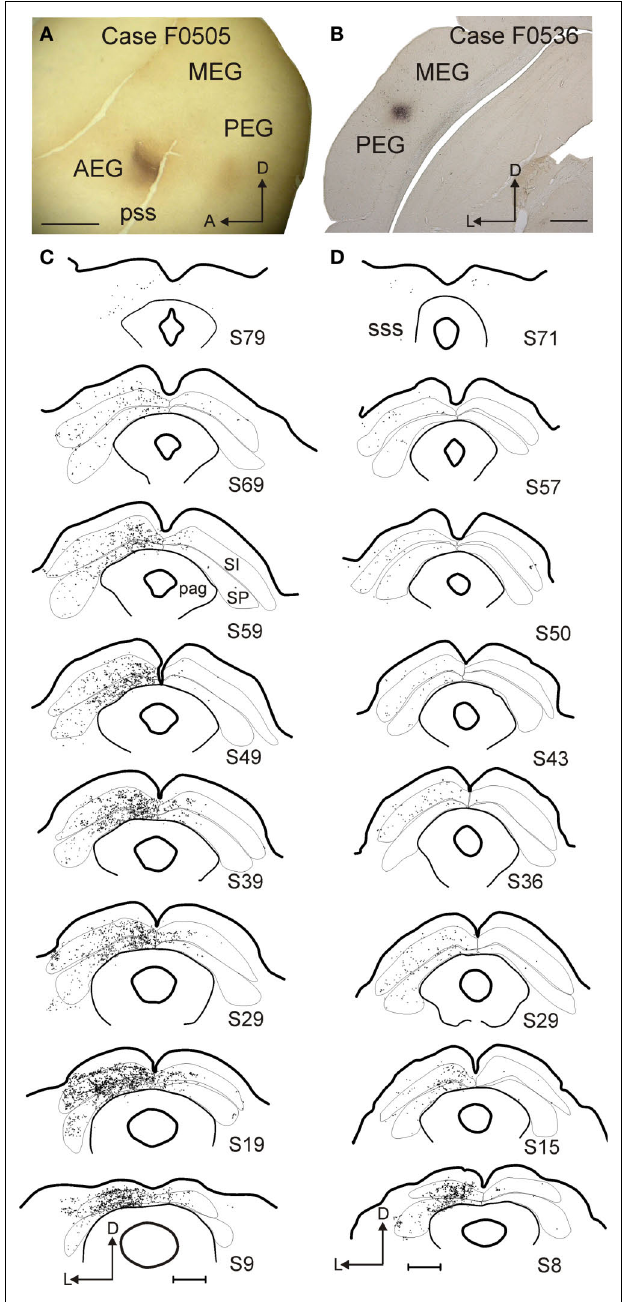
FIGURE 4 | Examples of two cases with BDA tracer injections in the auditory cortex. (A , B) Photomicrographs showing the location of the injection sites in AVF ( A , fl attened tangential section) and PEG ( B , coronal section). (C,D) Drawings of coronal sections at the level of the SC with each dot representing a terminal. Gray and white layers were combined for the intermediate (stratum intermediale, SI) and deep (stratum profundum, SP) SC. The number of the section in each drawing indicates its anteroposterior position, with zero indicating the most posterior corner of the SC. Calibration bars are 2 mm for (A) and 1 mm for (B – D) .